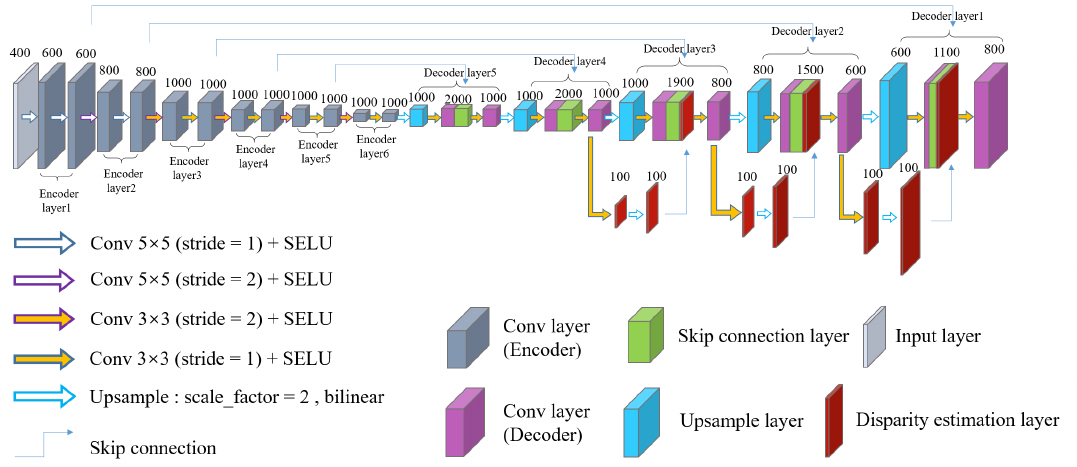
Figure 3. The structure of the multi-view disparity estimation method using an asymmetric network (MDEAN). Our proposed MDEAN contains six-layer encoder and five-layer decoder.